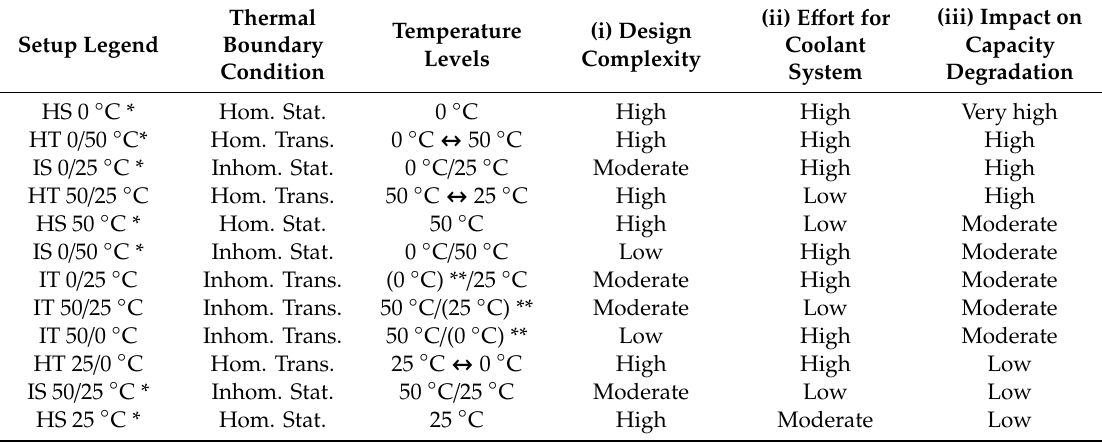
Table 5. Evaluation of the setups by means of their thermal boundary condition and its impact on degradation, sorted according to the capacity loss shown in Figure